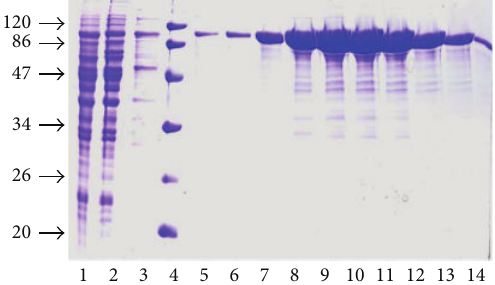
Figure 3: SDS-PAGE in 12% gel of the purified AMO using chromatography on Ni-NTA-agarose. (1) crude extract, 100 𝜇 g; (2) flow through the column, 100 𝜇 g; (3) washing with 8mM imidazole, 20 𝜇 L; (4) protein molecular weight markers (MW, kDa, 20, 26, 34, 47, 86, and 120; 1.2 𝜇 g of each protein); (5)–(14) elution fractions obtained in 10–500 mM imidazole gradient, 20 𝜇 L. Figure4:MAconcentrationintheaqueousphaseoftheCFBRupon